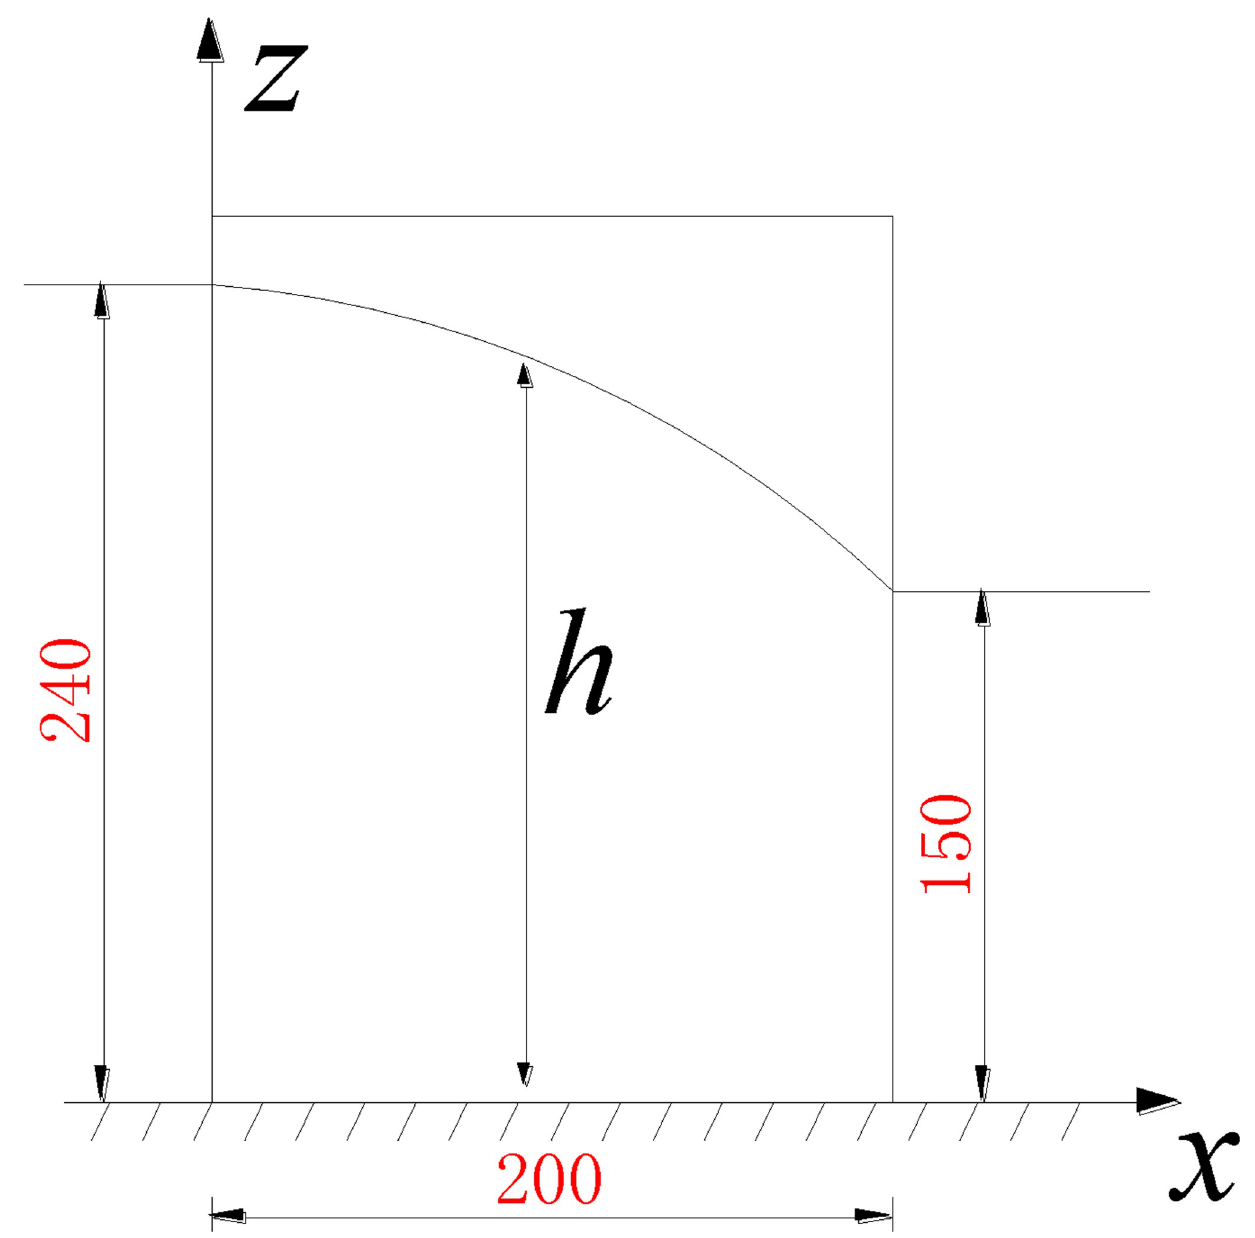
Fig 8. Simplified 2D schematic of seepage